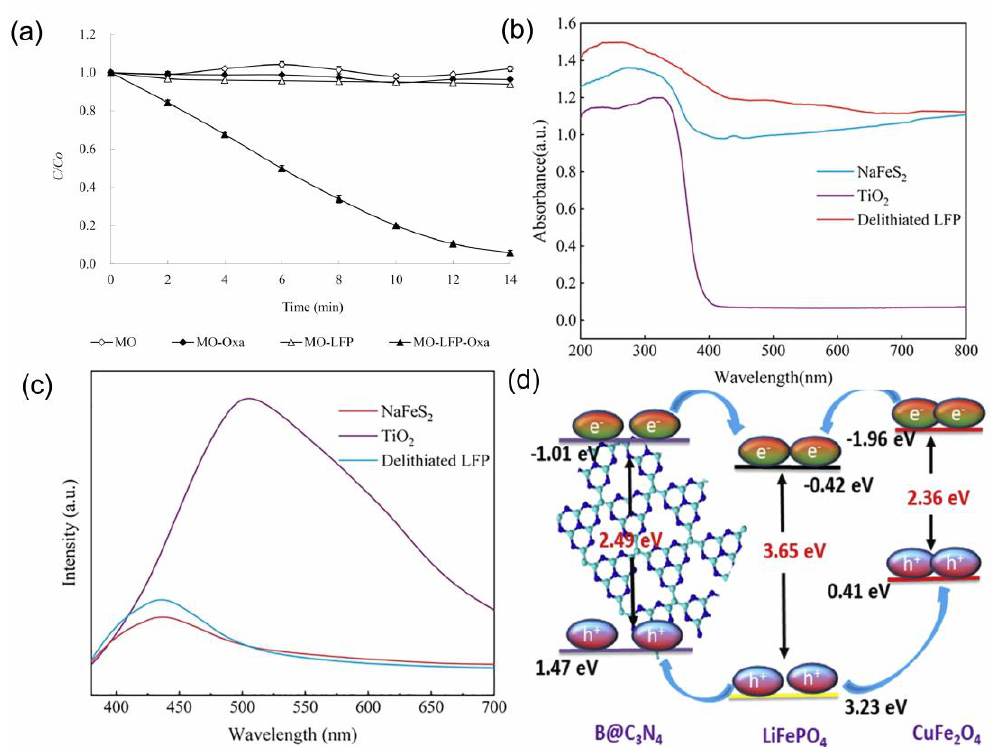
Figure 8. ( a ) Photodegradation of MO under varying conditions, ( b ) UV − vis diffuse reflectance spectra, ( c ) photoluminescence (PL) spectra, and ( d ) schematic diagram for charge separation and transfer in BLC − 3 junction. Reprinted with permission from ref [25,62,109].